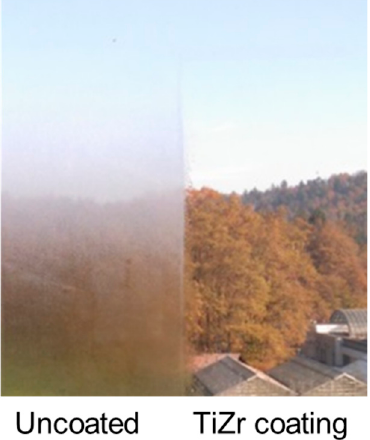
Figure 6. The anti-fogging effect of the TiZr coating on the office window. The picture was taken on 20 October 2017 after one month of exposure time.